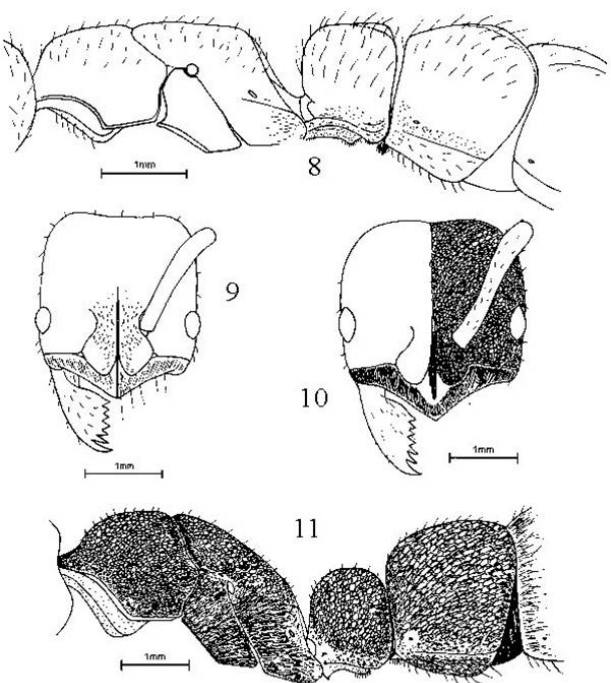
Fig 8 . The lateral view of the holotype worker of B. cariosa (MCSN). Fig 9 . The head of the holotype worker of B. cariosa (MCSN). Fig 10 . The head of the holotype worker B. cavernosa showing sculpture on the left side of the head (MfN). Fig 11 . The lateral view of the holotype worker of B. cavernosa